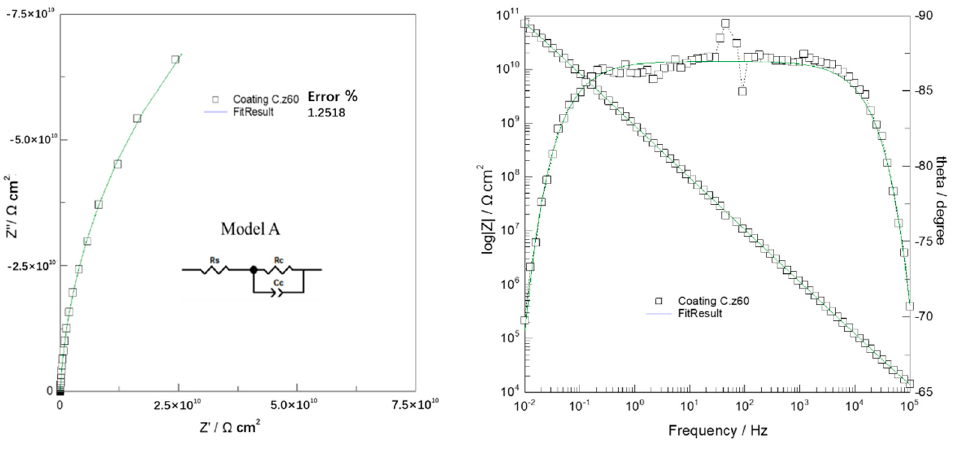
Figure 5. Nyquist and Bode diagrams of EIS measurements of 2024 Al-alloy coated with the coatings containing different ratios of GLYMO immersed in 5 wt.% NaCl solution. ( a ) 0.5 h; ( b ) 150 h; ( c ) 690 h; ( d ) 1050 h.